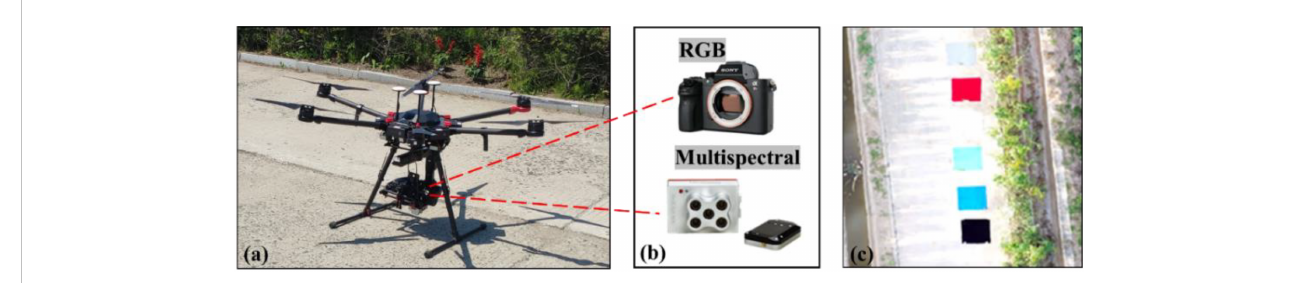
FIGURE 2 The UAV platform and sensors: (A) DJI M600 pro, (B) Sony a 7RII and MicaSense RedEdge-MX, and (C) six tarpaulins of different